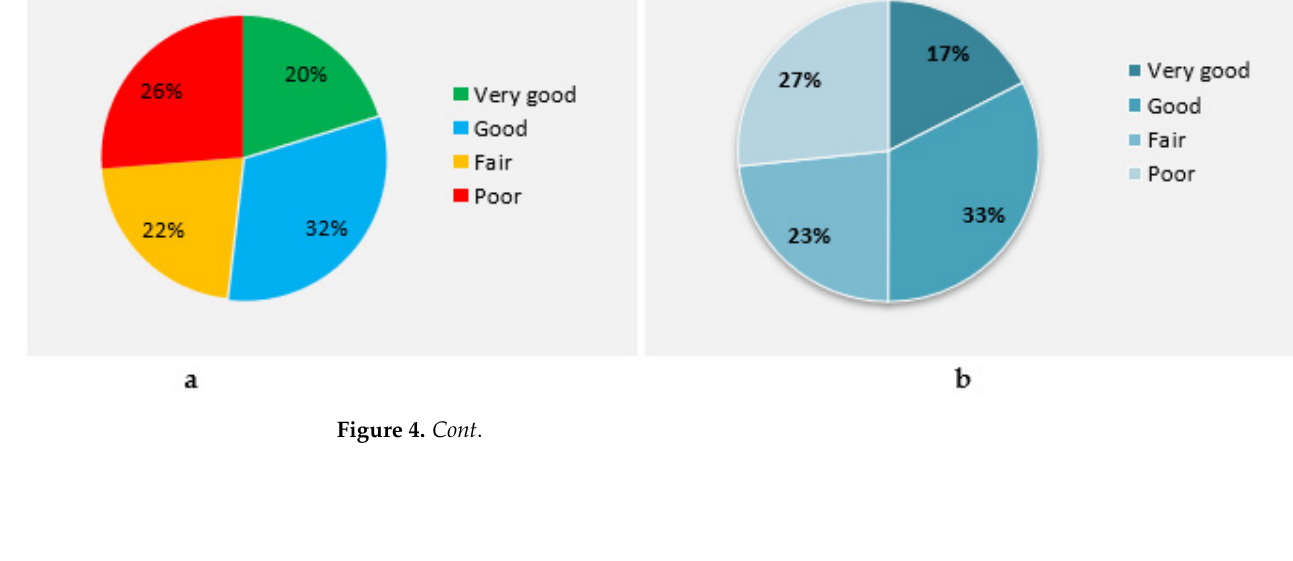
Figure 4. Field survey results of longitudinal drainage inlet conditions for overall inlet conditions ( a ), curb inlets ( b ), combined inlets ( c ) and grate inlets ( d ). 3.1.2. AHP Model Correlation Results As per verifications performed through site investigation, the AHP results obtained from technical interviews and focal group discussions gave a very strong correlation. As shown in Figure 5, the AHP tool is acceptable and can be used as a good qualitative meas- ure of multicriteria decision making. Correlation results of 0.93 and 0.96 are obtained for cross- and longitudinal drainage infrastructures, respectively. ( a ) ( b ) Figure 5. Correlation result of failure causes through site observation and AHP model results for cross–drainage ( a ) and longitudinal drainage ( b ) structures. y = 0.9369x + 1.2627 R² = 0.9333 010203040 0